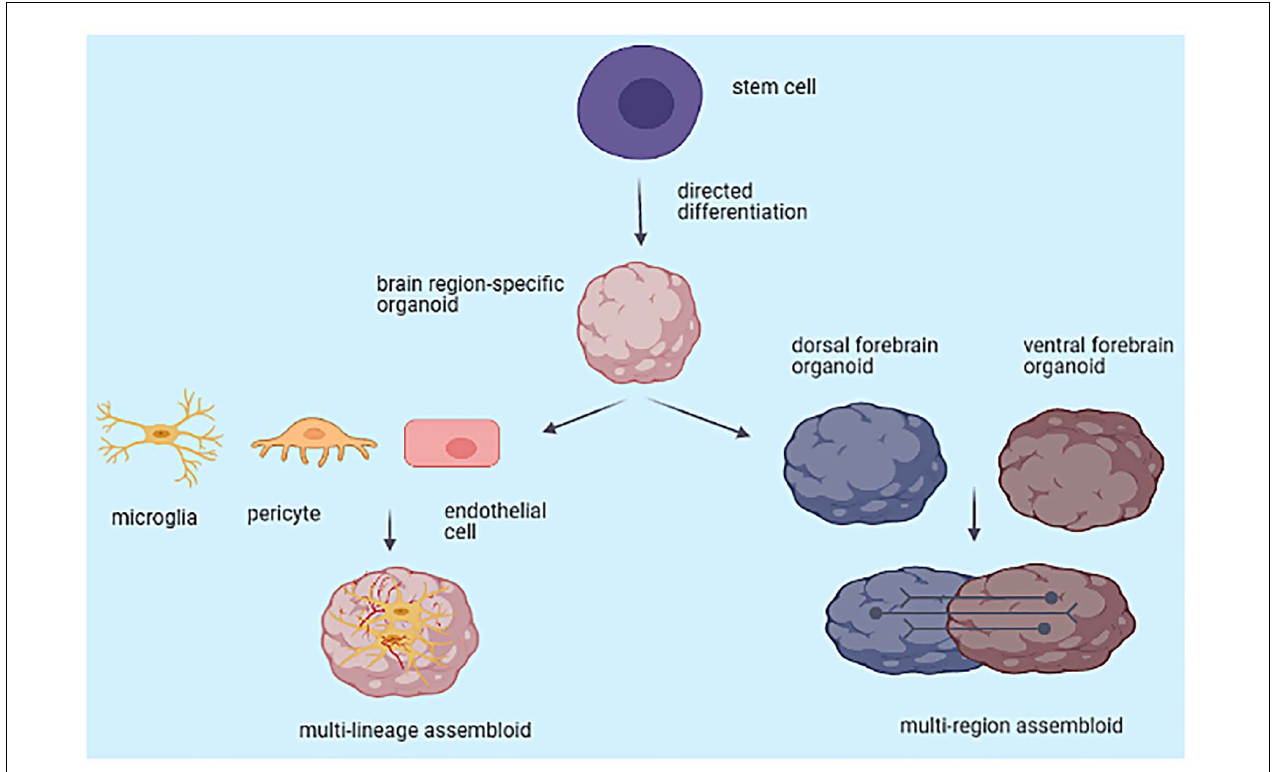
FIGURE 2 | Generation of multi-region and multi-lineage brain assembloids from stem cells.